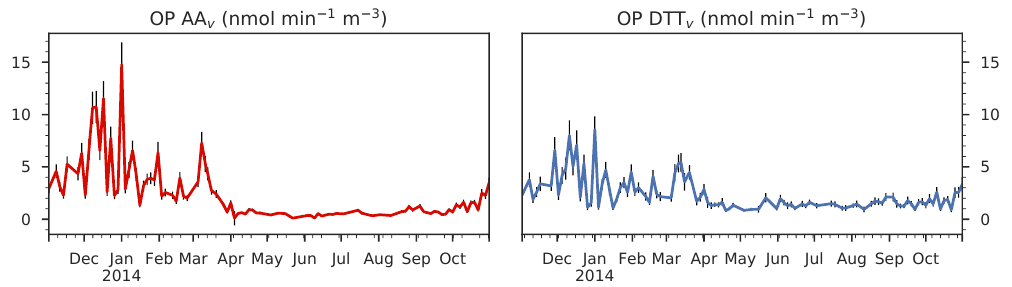
Figure 2. OP AA v and OP DTT v variation from 2 November 2013 to 31 October 2014 (98 samples) at the Chamonix station. The er- ror bars represent the uncertainties (standard deviation) of the measurement. The OP unit is normalized by volume and is expressed in nmolmin − 1 m − 3 .